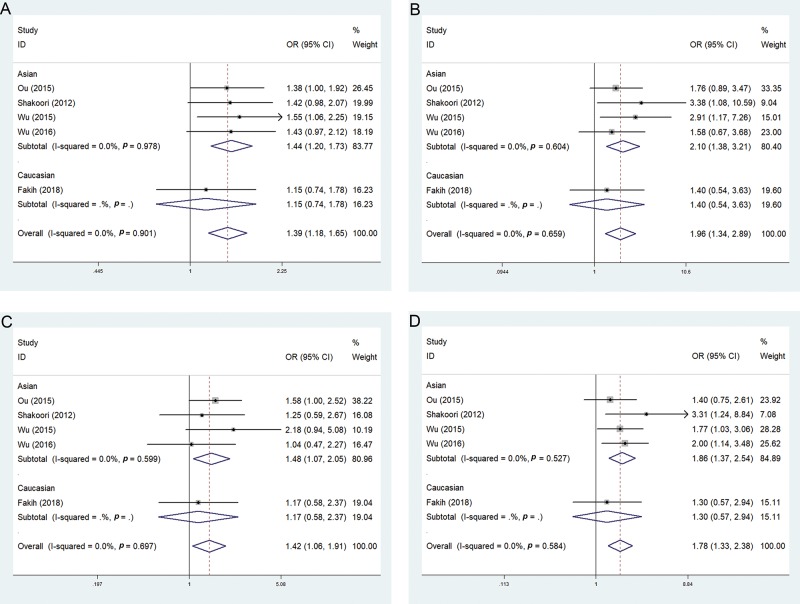
Forest plots of the association between the rs721917 polymorphism and the risk of COPD (A, allelic model; B, additive model; C, recessive model; D, dominant model).